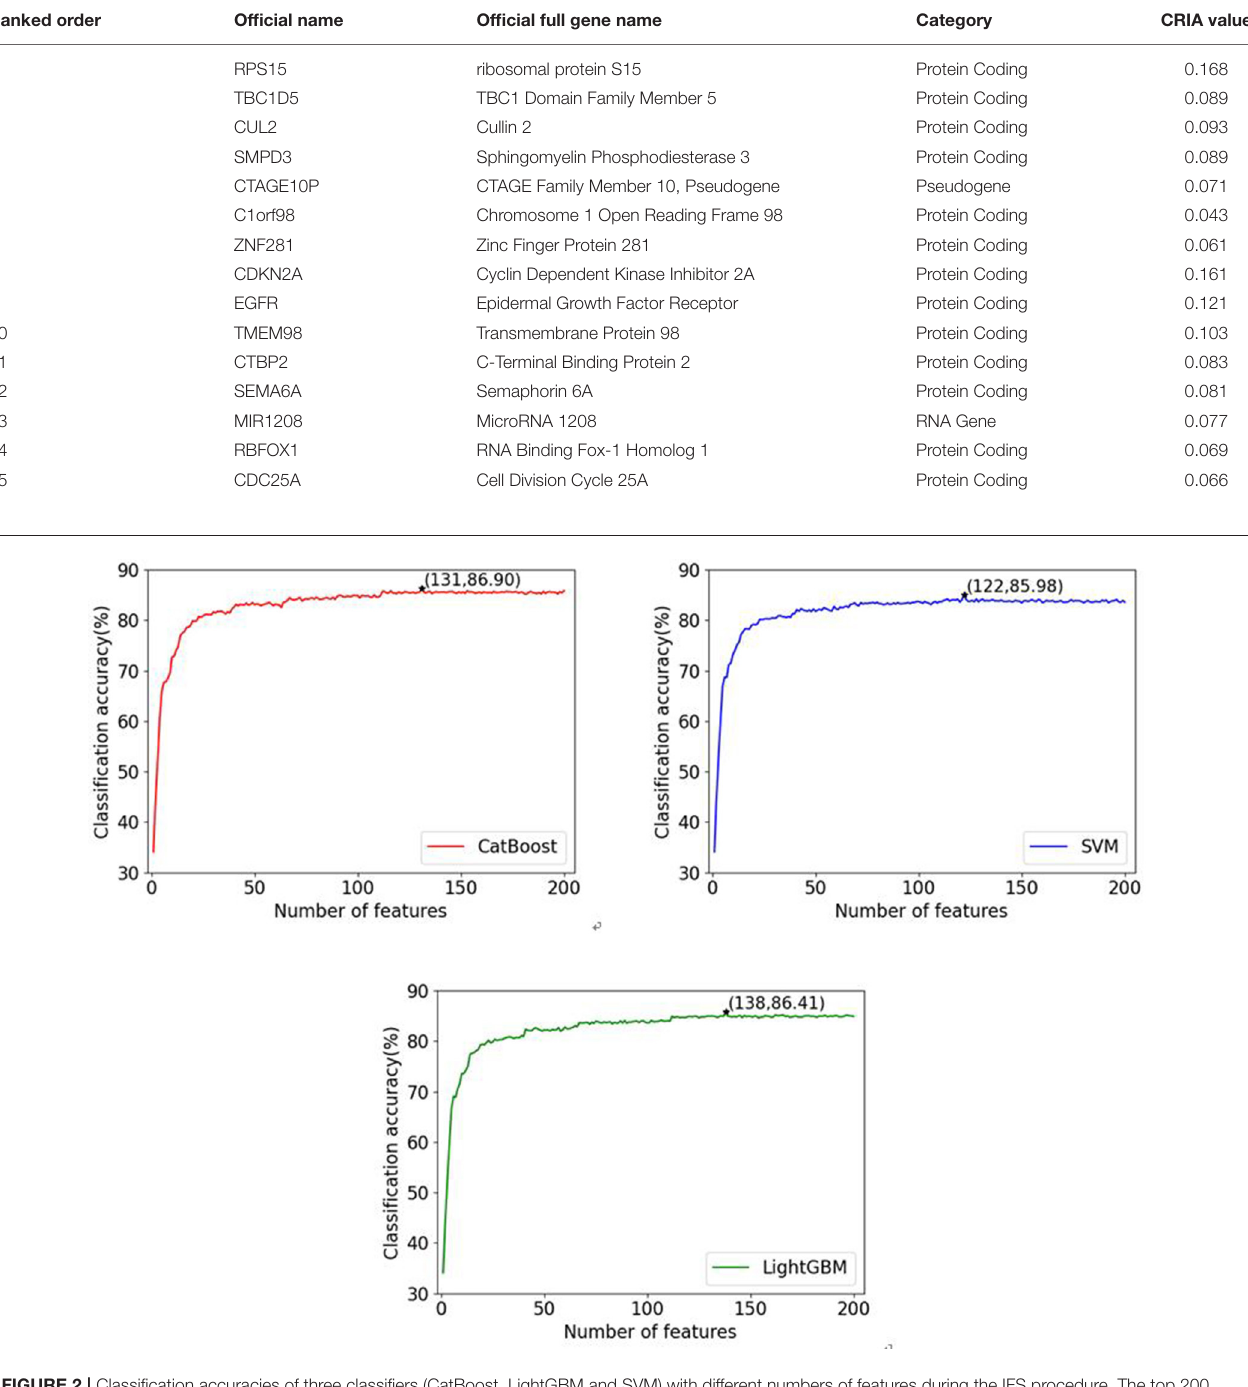
where T P , T N , F P , and F N denotes the numbers of true positives, true negatives, false positives, and false negatives